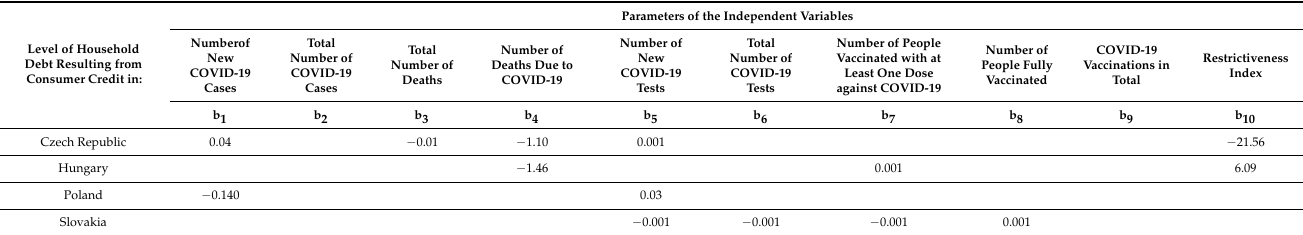
Table 1. Results of multiple linear regression analysis. Step